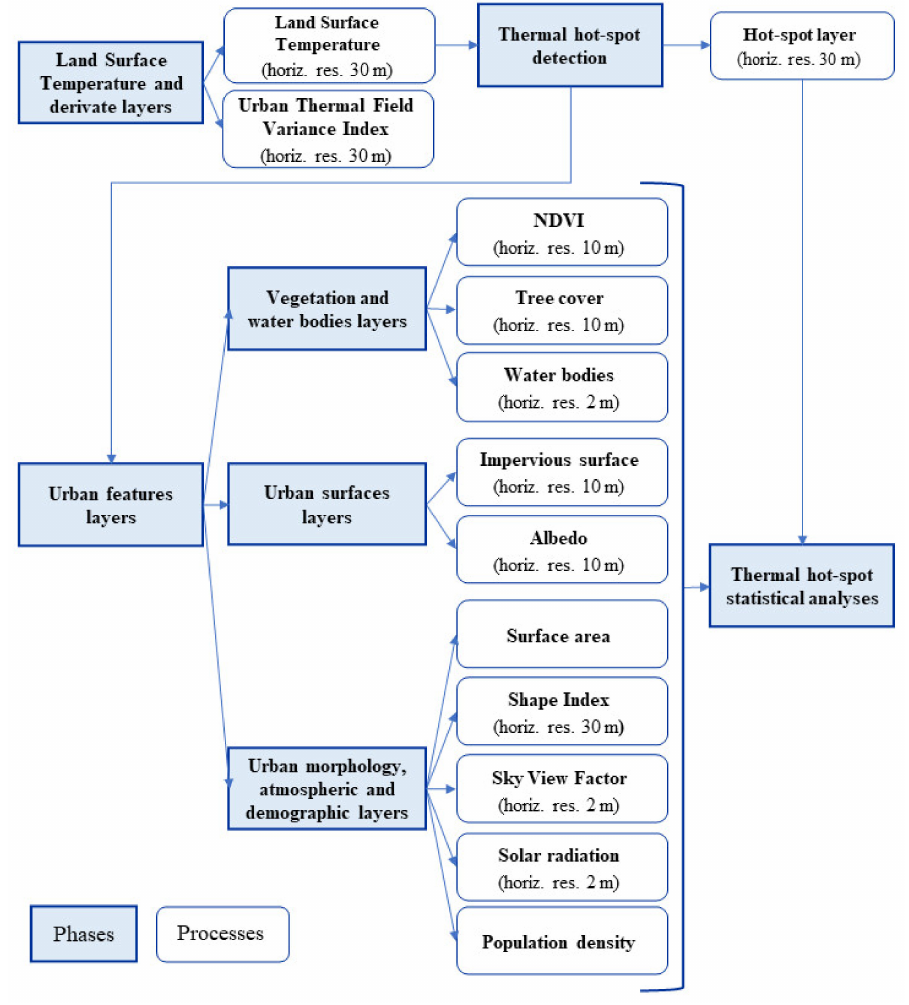
Figure 1. Workflow of data